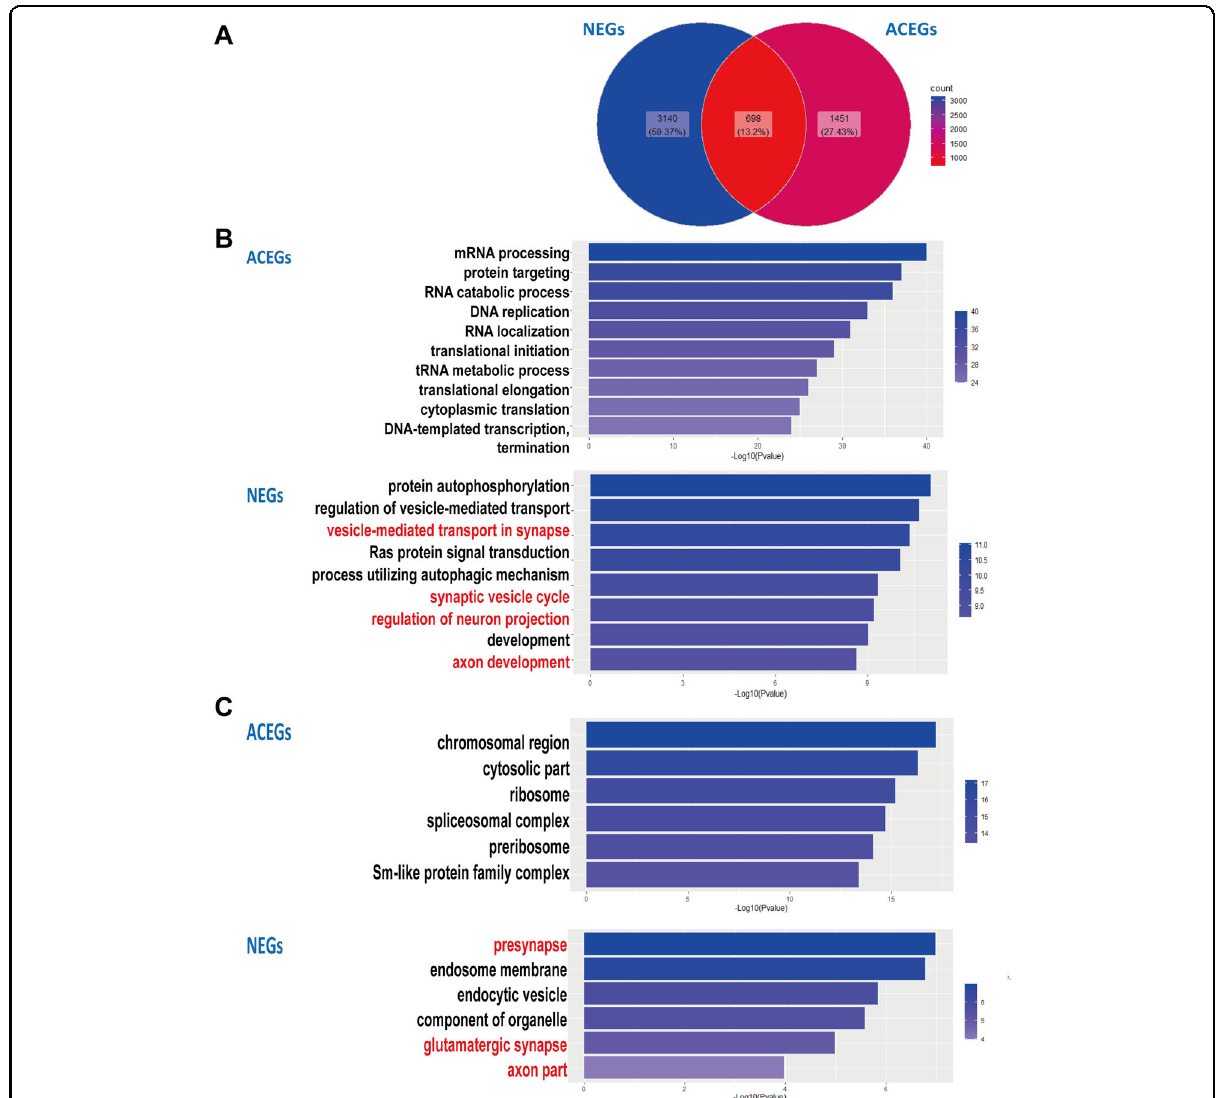
Fig. 1 Gene ontology (GO) analysis of essential genes. a Venn diagram shows overlapping of Neuronal Essential Genes (NEGs) and Achilles Project-speci fi c essential genes (ACEGs). b Top biological process GO terms enriched in NEGs and ACEGs. c Top cellular component GO terms enriched in NEGs and